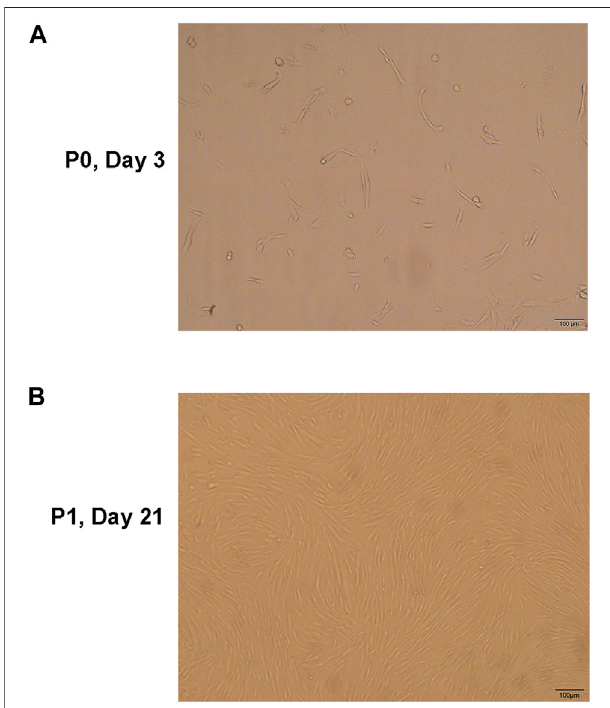
FIGURE 3 | (A) The hNPMSCs exhibited a short, rod-like shape in primary culture. (B) The hNPMSCs showed uniform spindle fi lament spiral growth after